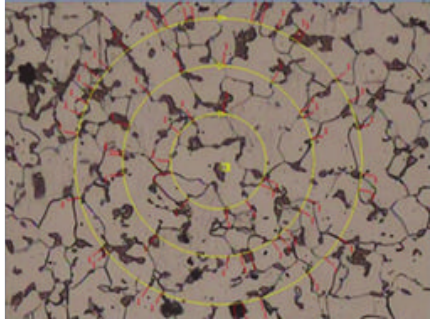
Figure 4: Circular Intercept is composed of a set of 3 concentric